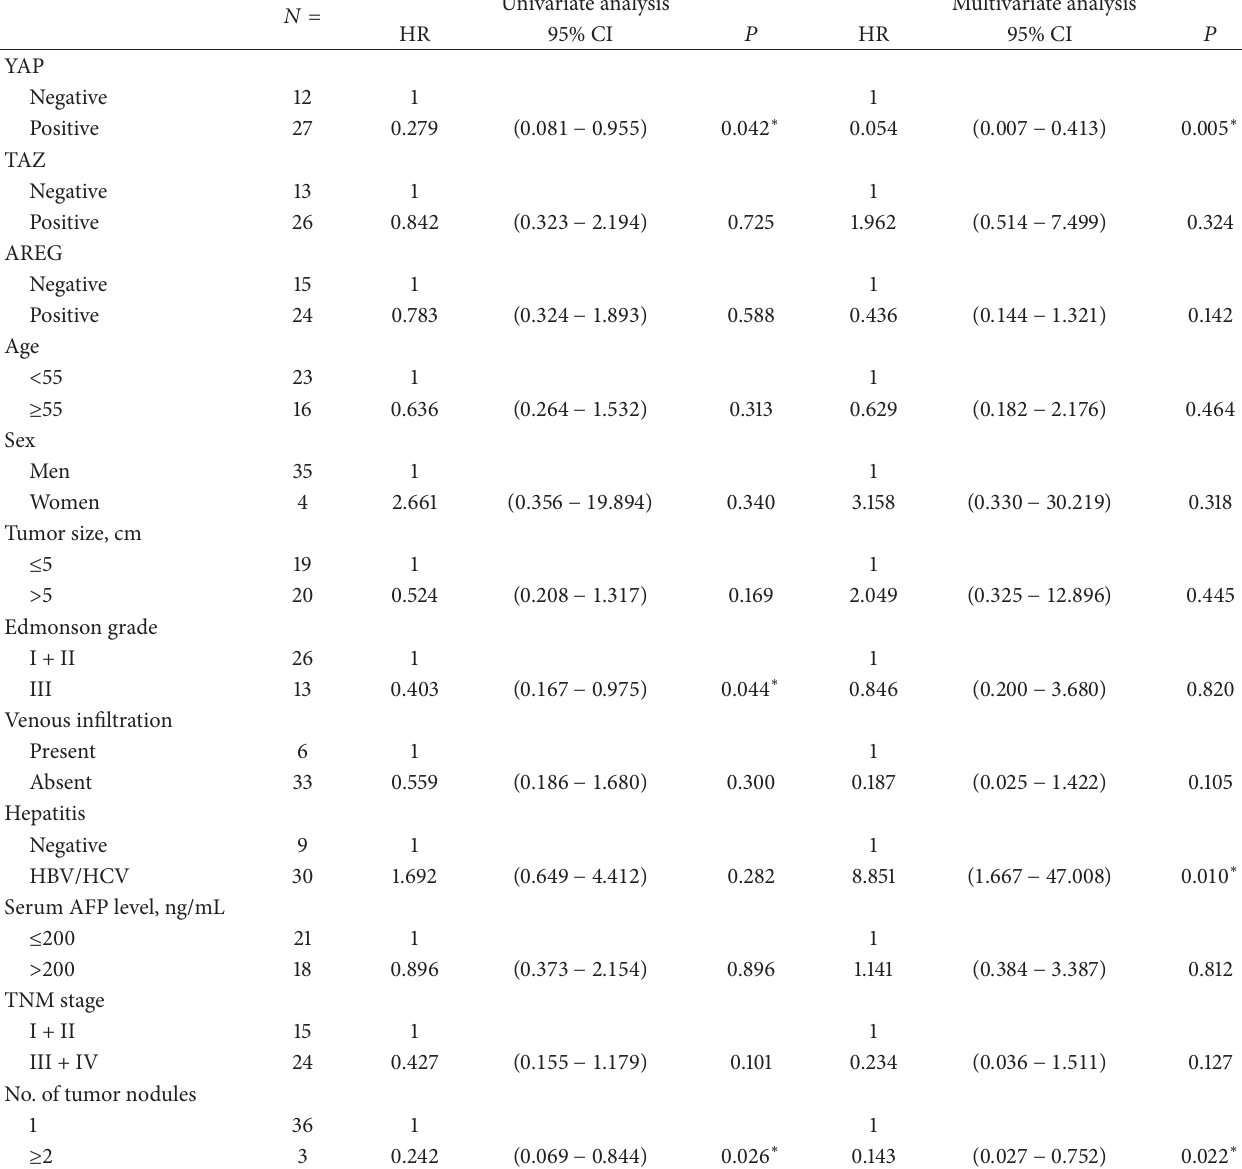
Table 3: Cox regression analysis of overall survival ( 𝑛 = 39